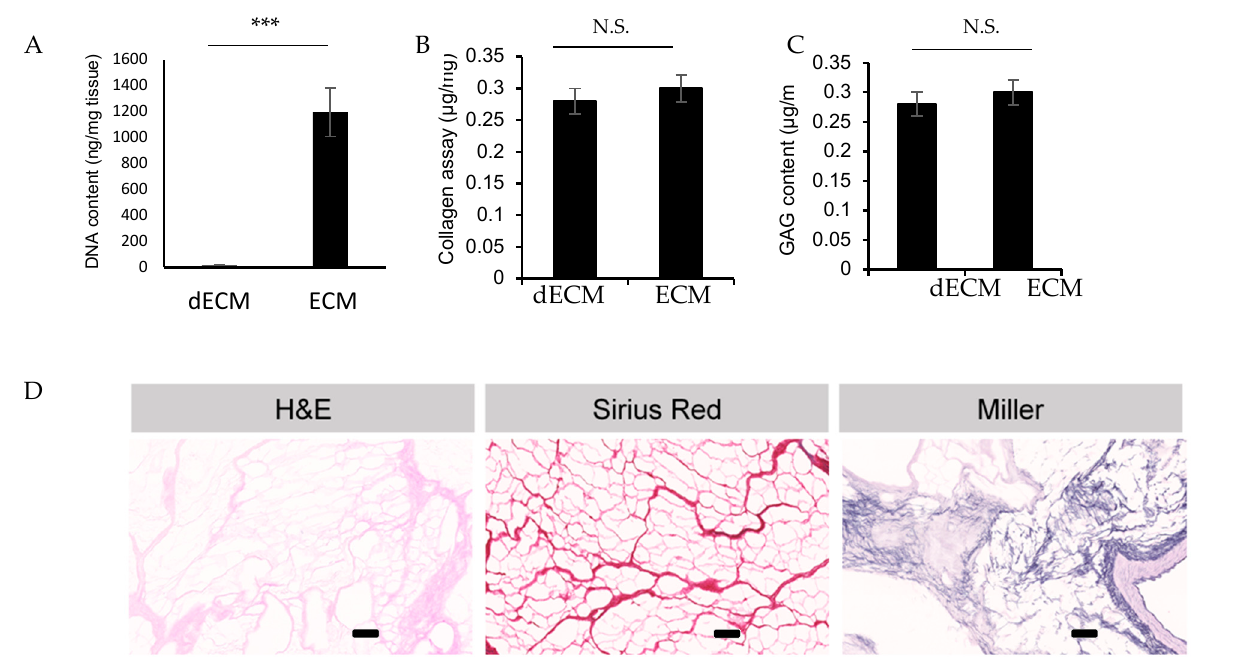
Figure 2. dECM characterization. Content of DNA ( A ), Collagen ( B ), and GAG ( C ) in the dECM after lyophilization and dissolving in lysis buffer is presented. All amounts relative to the weight of fresh tissue used. ( D ) H&E, Sirius red and Miller staining show nuclei, collagen and elastin, respectively, to prove removal of the DNA and the presence of collagen and elastin. *** = significant difference for p < 0.001 (N = 3–4 per condition), N.S. = Not Significant for p > 0.05. Scale bar: 100 µ